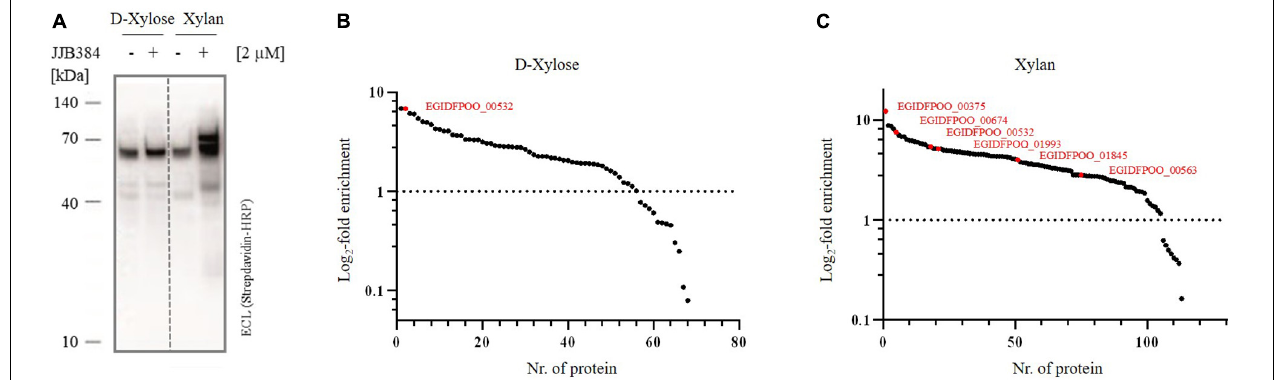
FIGURE 6 | CAZymes identified by ABPP with JJB384. (A) Western blot analysis of the in vivo profiled Thermococcus sp. strain 2319x1E proteome of cells grown on either D -xylose or xylan after separation via Bis-Tris gel electrophoresis and detection with a streptavidine-HRP conjugate. The cells were incubated with 2 µ M JJB384 for 2 h at 78 ◦ C with constant shaking. (B,C) Log 2 -fold changes for all proteins enriched with JJB384 in cells grown on D -xylose (B) or xylan (C) compared to the respective DMSO-controls lacking the probe. Predicted CAZymes are depicted in red. Each treatment group comprised three biological